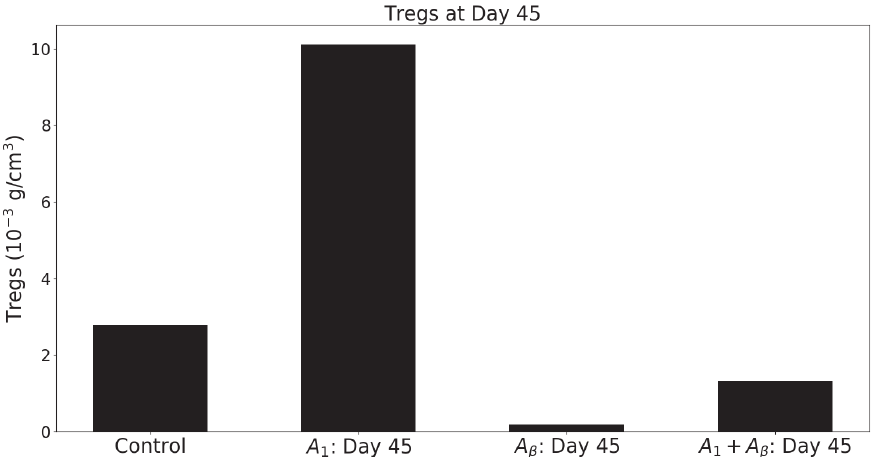
Fig 4. Tregs levels in all treatment combinations with anti-PD-1 and anti-TGF- β . The bar plots represent the density of Tregs in the control, anti-PD-1 only, anti-TGF- β only, and anti-PD-1+anti-TGF- β cases. Tregs increase with anti-PD-1 as single agent, decrease significantly with anti-TGF- β as single agent, and decrease (but remains below the control case) when anti-PD-1 is combined with anti-TGF- β .